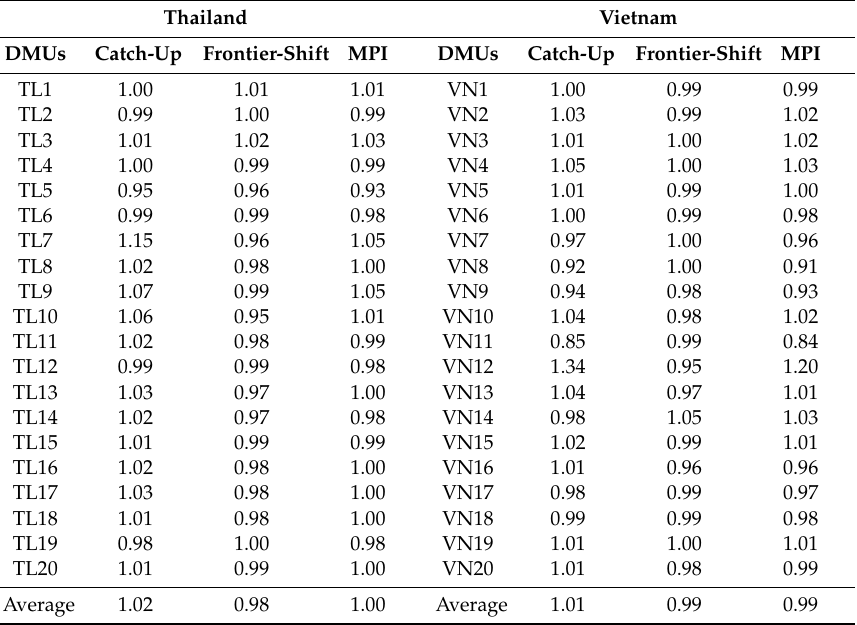
Table 9. E ffi ciency improvement during